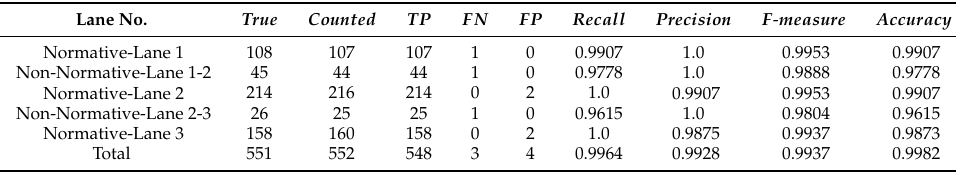
Table 8. The counting results of Zhongshan Rd.